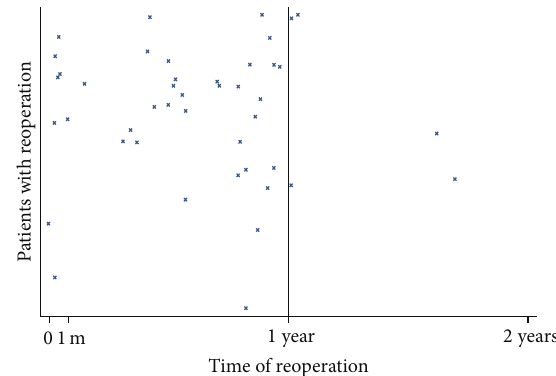
Figure 1: Timing of reoperations following contralateral risk- reducing